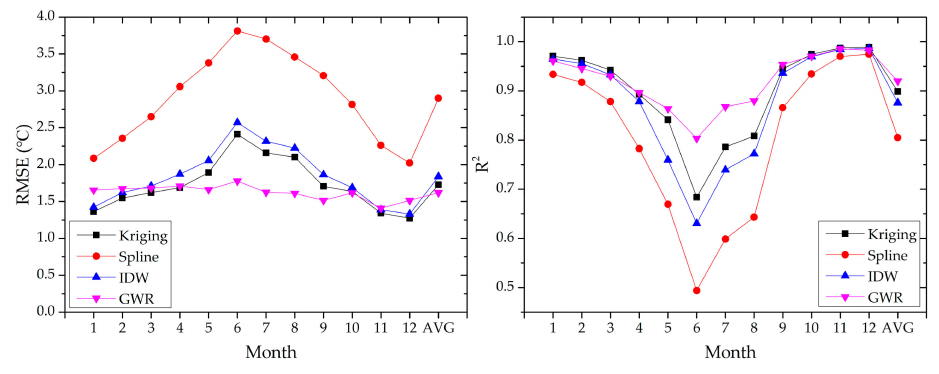
Figure 4. RMSE and R 2 of the predicted monthly mean near surface air temperature using geographically weighted regression and three interpolation methods in China in 12 months of 2010.